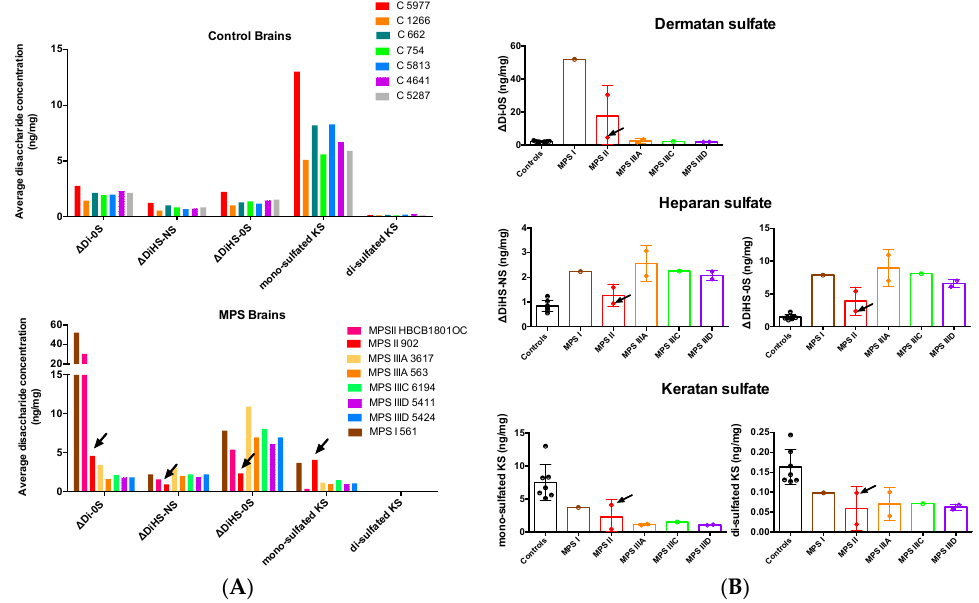
Figure 1. Glycosaminoglycans (GAGs) levels in the brains of mucopolysaccharidosis patients and controls. Levels of disaccharides produced by enzymatic digestion of dermatan sulfate (DS) ( Δ Di-0S, Δ DiHS-NS) and heparan sulfate (HS) ( Δ DiHS-0S) as well as mono-sulfated and di-sulfated keratan sulfate (KS) were measured by tandem mass spectrometry and expressed ( A ) for the individual MPS patients and controls or ( B ) grouped according to the type of MPS disorder. Statistical significance of changes was estimated using Mann–Whitney multiple comparison test. Arrows indicate values detected in the tissues of non-neurological MPS II patient 902.